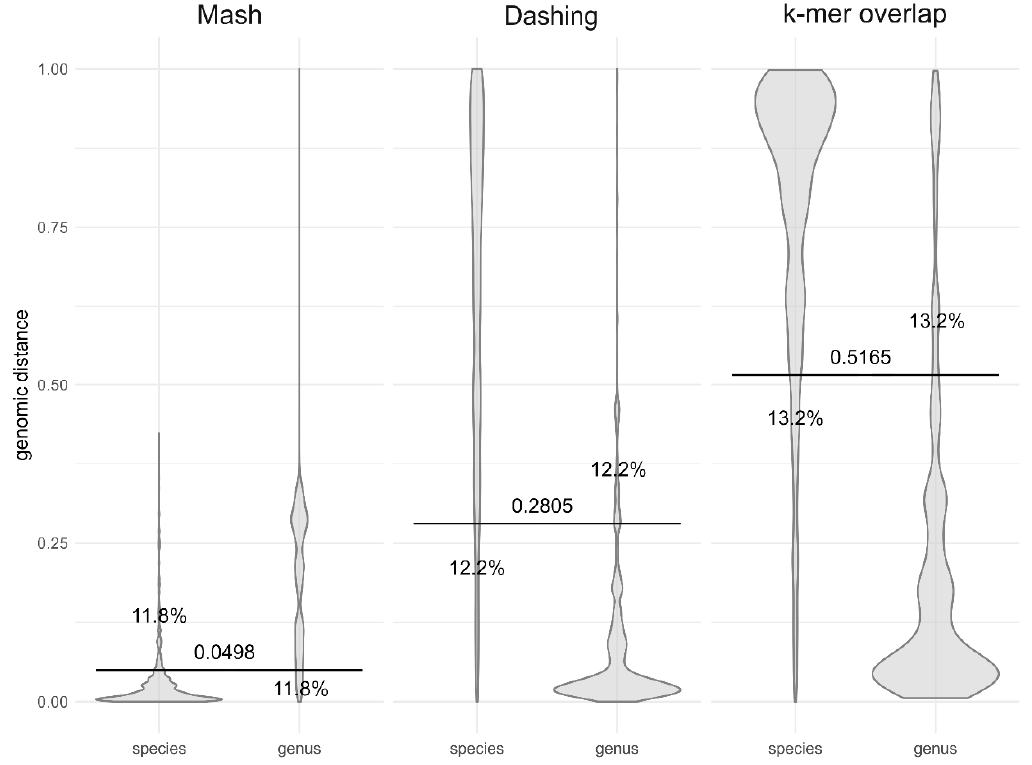
Figure 3. Comparison of different methods of genomic distance calculation in separating the within-